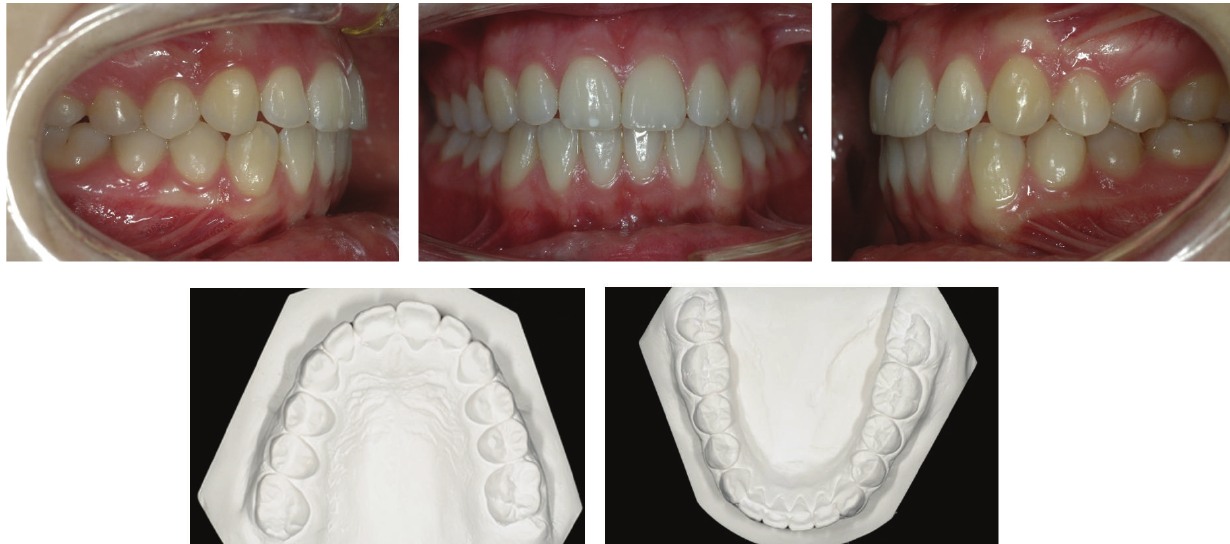
Figure 6: Posttreatment intraoral photographs and study casts (occlusal view).